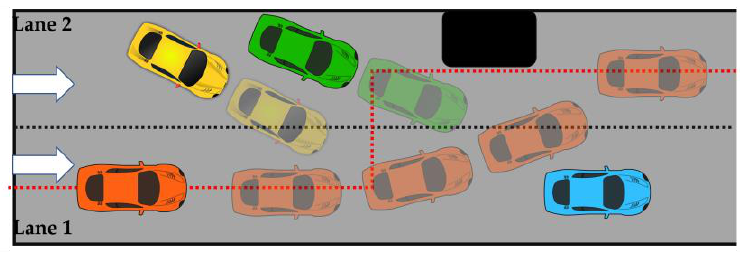
Figure 8. The sketch of the scenario in Experiment 4.